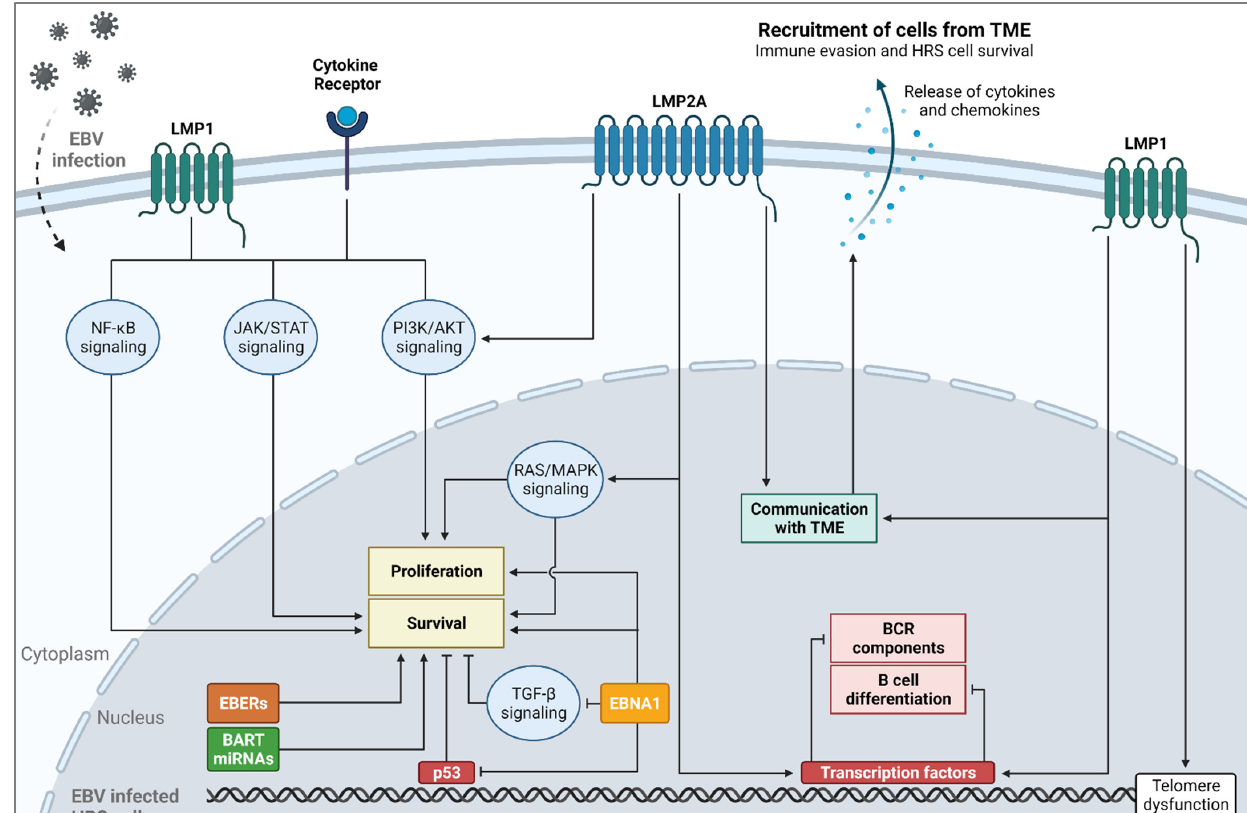
Figure 3. Schematic overview of EBV-associated gene products in the pathogenesis of classical Hodgkin lymphoma. EBV-associated transcripts and proteins are able to activate pathways and cellular processes that are recurrently affected by mutations in EBV-negative HRS cells. These alterations thereby play an important role in the pathogenesis and survival of EBV-positive HRS